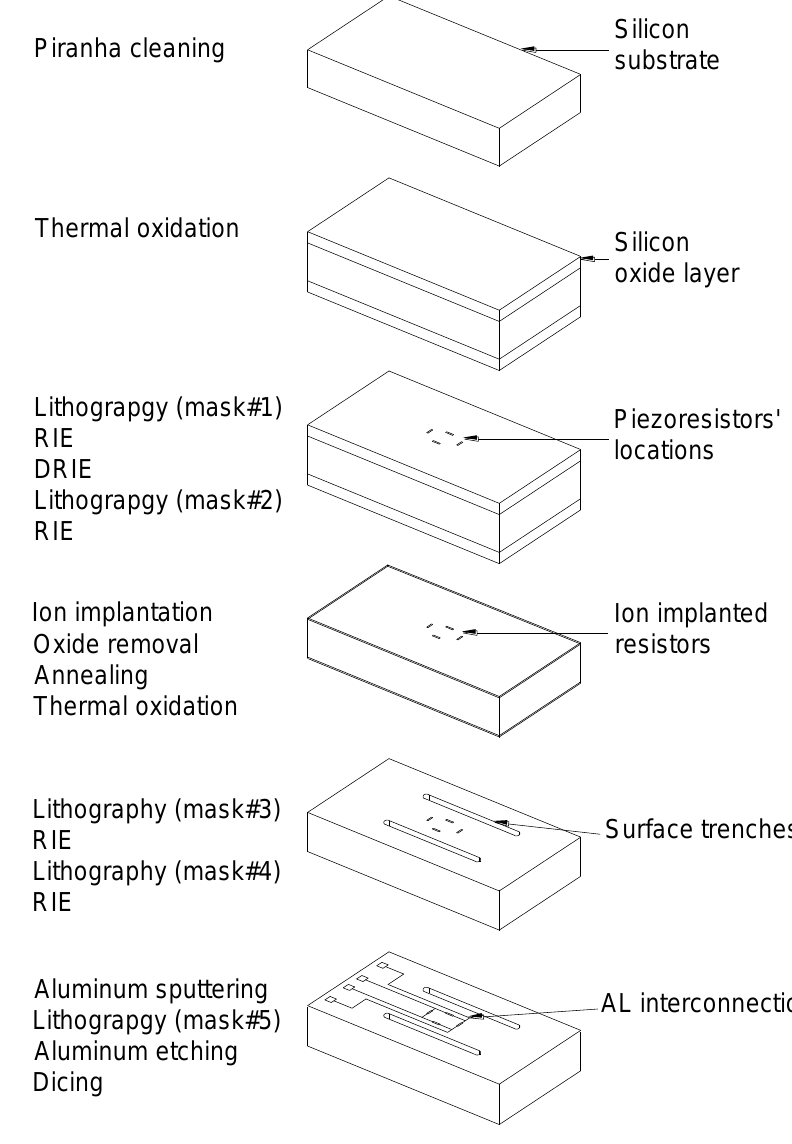
Figure 9. Microfabrication process flow to build the sensing